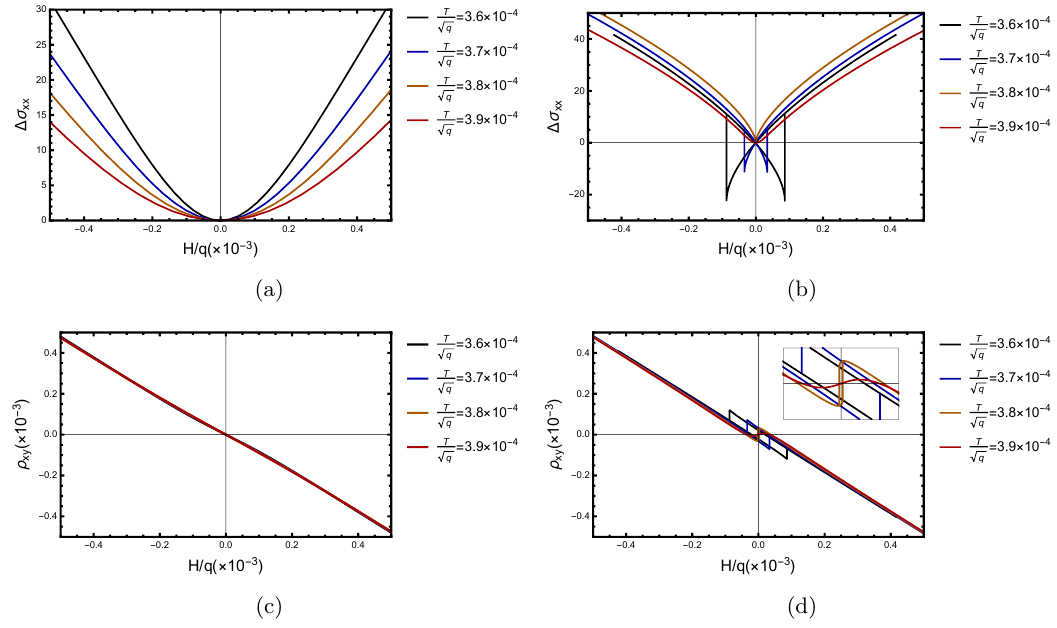
Figure 4 . (a) and (c) corresponds to blue dots in figure 1 while (b) and (d) corresponds to red dots in figure 1. ∆ σ xx is the subtracted conductivity like figure 2. These are also comparable to experimental data in figure 3 of [4].